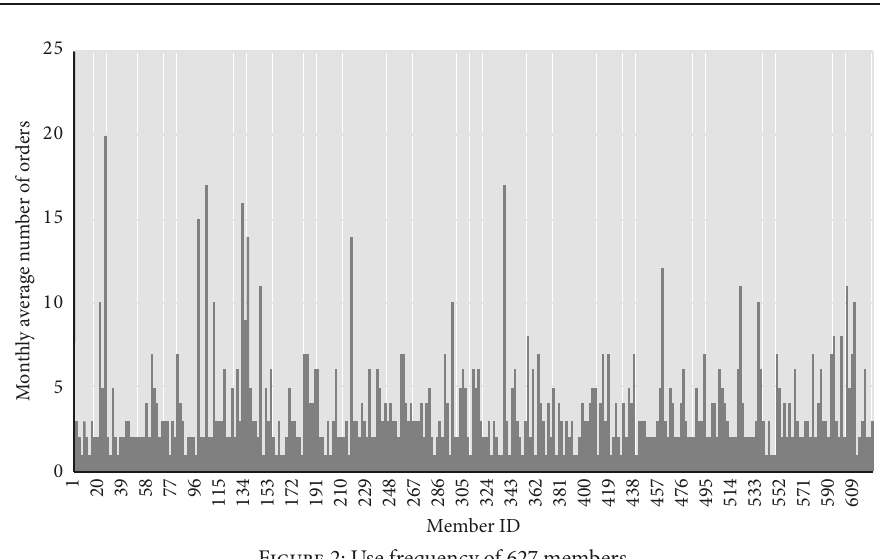
Figure 2: Use frequency of 627